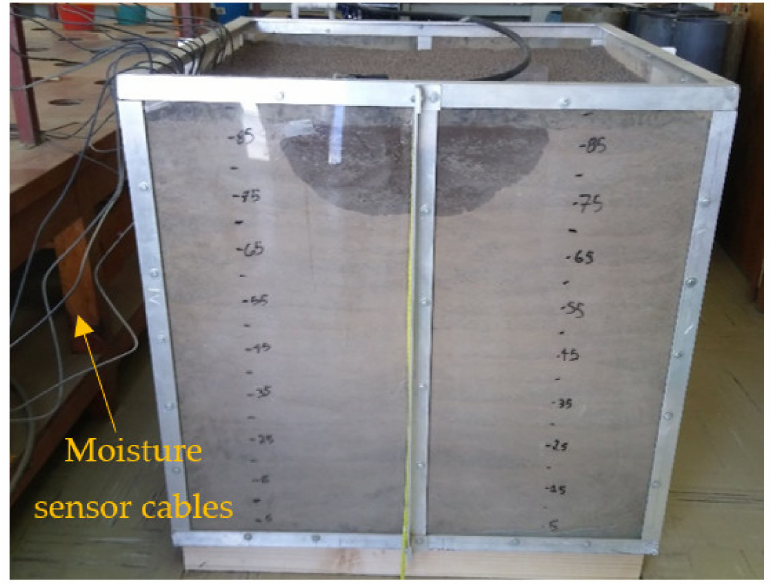
Figure 2. Observation wall of the wetting